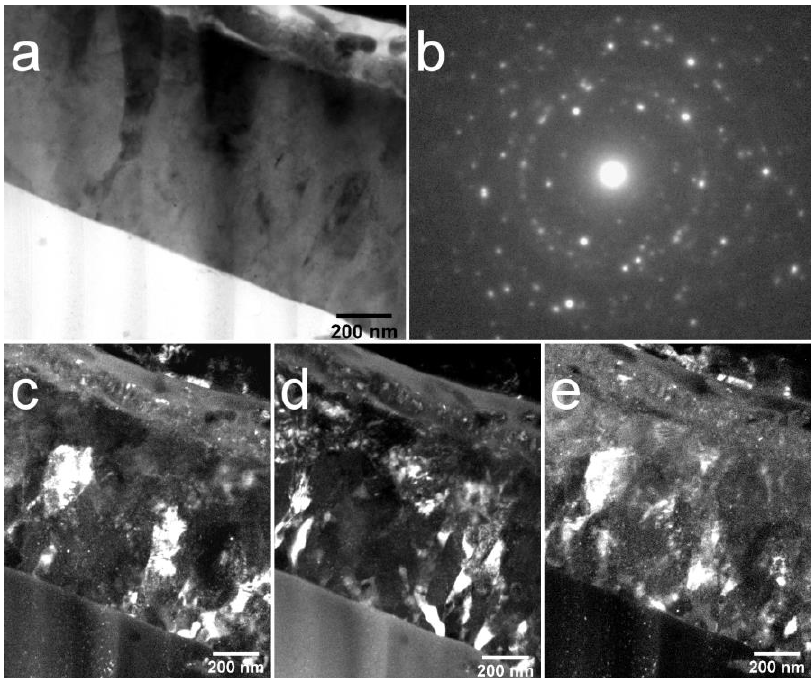
Figure 9. TEM image of the cross-section of Cu-HA coating on Ti after HT at 750 °C BF image ( a ), selected area electron diffraction (SAED) obtained from the coating region ( b ), DF in reflex (002) ( c ), DF in reflex (112) ( d ), and DF in reflex (213) ( e ).